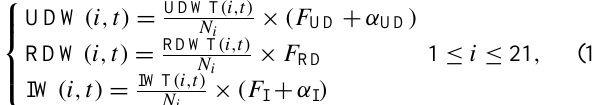
Fig.2. (a) Land use types after Shu’s model (2010); (b) Soil types; (c) Hydrogeological units 988 of model layer 1 after the groundwater model of Cao et al. (2013); (d) Hydrogeological 989 units of model layers 2 and 3 after the groundwater model of Cao et al. (2013). 990